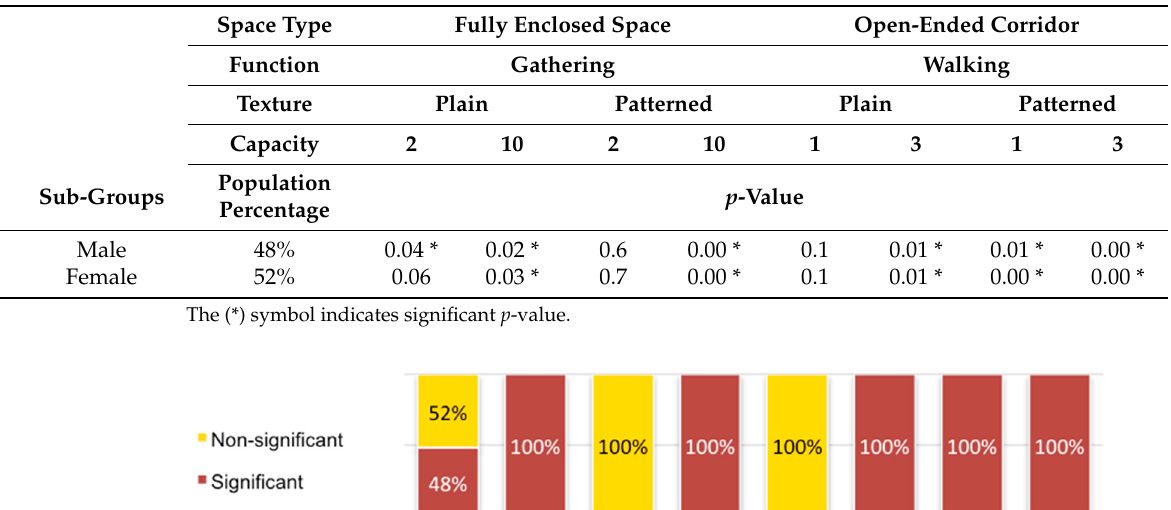
Table 3. Gender perception filter and comparisons of space size variations between IVRIE and DT systems.